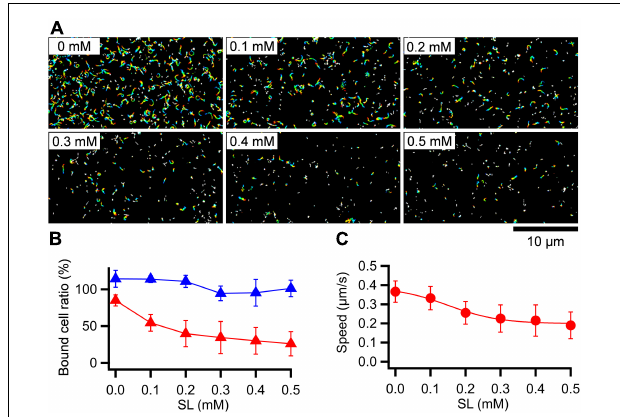
FIGURE 3 | Effects of SL on binding and gliding. (A) Gliding cells were treated with free SL. The cell trajectories after SL treatment are presented as a stack for 20 s, changing color from red to blue. SL concentrations are shown at left upper of each panel. (B) Number of cells bound to the glass at 5 min after the treatment are plotted relative to the initial cell number. The averages for gliding (red triangles) and non-gliding (blue triangles) cells are shown with the standard deviations ( n = 10, 10, 10, 10, 9, 10 for 0, 0.1, 0.2, 0.3, 0.4, 0.5 mM, respectively). (C) Averaged gliding speeds under various SL concentrations are plotted with the standard deviations and fitted by a sigmoidal curve ( n = 50, 50, 50, 50, 56, 56 for 0, 0.1, 0.2, 0.3, 0.4, 0.5 mM, respectively).